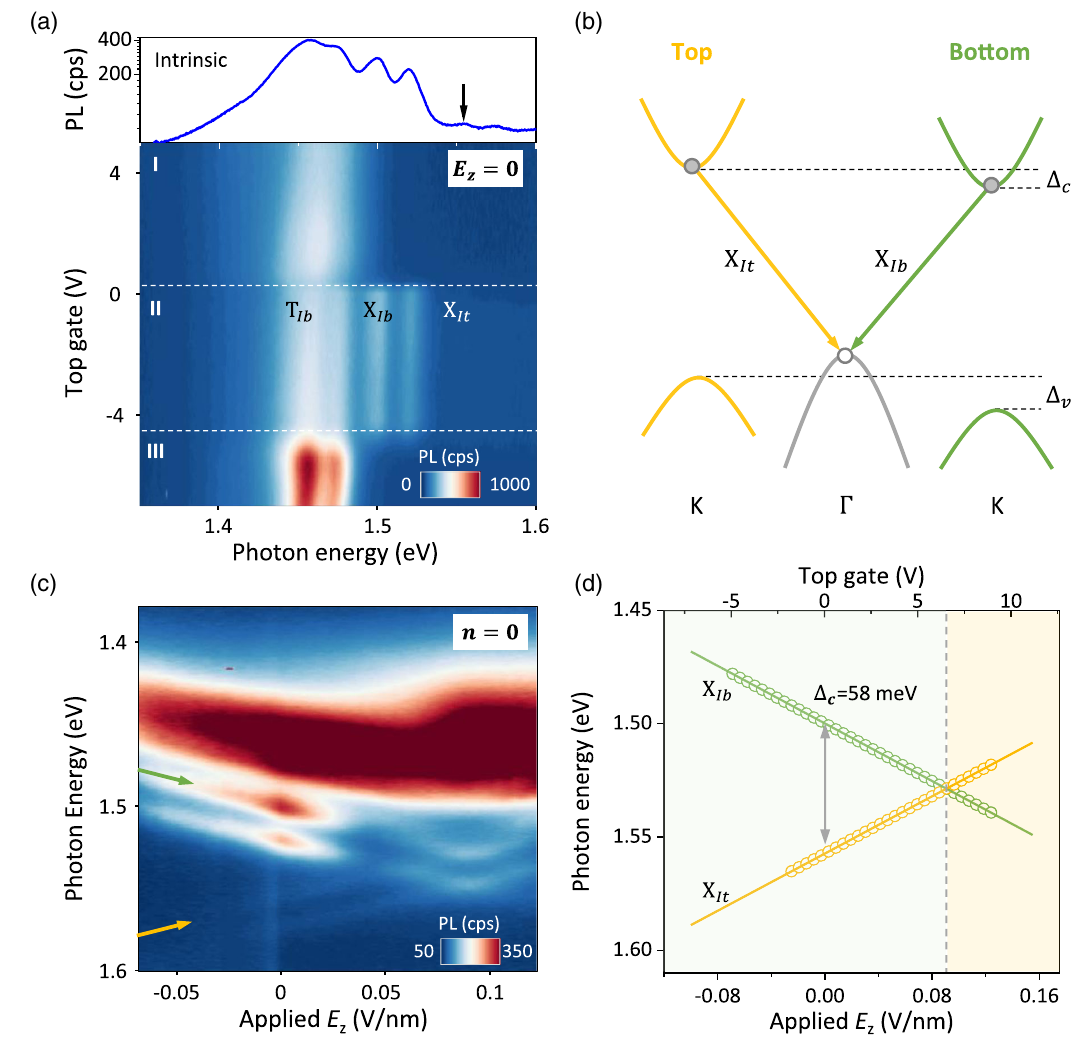
FIG. 4. Doping-dependent and electric-field-dependent photoluminescence spectrum of Γ - K interlayer excitons in the 3 R -MoS 2 bilayer. (a) Contour plot of the doping-dependent PL spectrum of momentum-indirect interlayer excitons in the 3 R -MoS 2 bilayer without an external electric field. The gate voltage is applied proportionally on top and bottom gates with relation V doping, from low energy to high energy, three pairs of peaks indicate T (interlayer Γ - K exciton), respectively; X region II with the black arrow denoting the X stacked MoS 2 bilayer at K points of the Brillouin zone and momentum-indirect Γ - K transitions. Δ offset and valence band offset at K points, respectively. (c) Contour plot of the electric-field-dependent PL spectrum in the 3 R -MoS 2 bilayer with zero doping. The green (yellow) arrow denotes the interlayer exciton X top and bottom gates with relation V denote the linear fitting results. The dashed gray line denotes the same energy of X